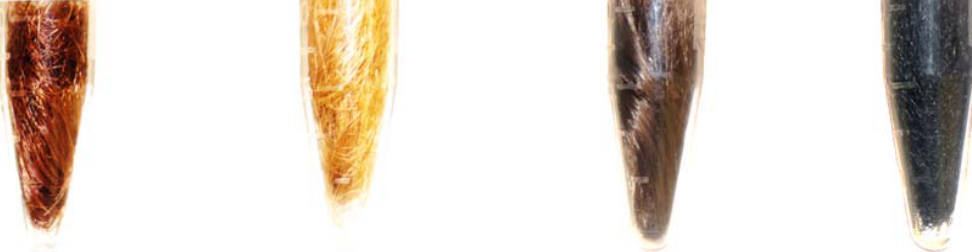
Figure 1. Images of hair samples obtained from donors of different skin phototypes (from left to right): red hair (phototype I), blond hair (phototype II), chestnut hair (phototype III) and black hair (phototype V).